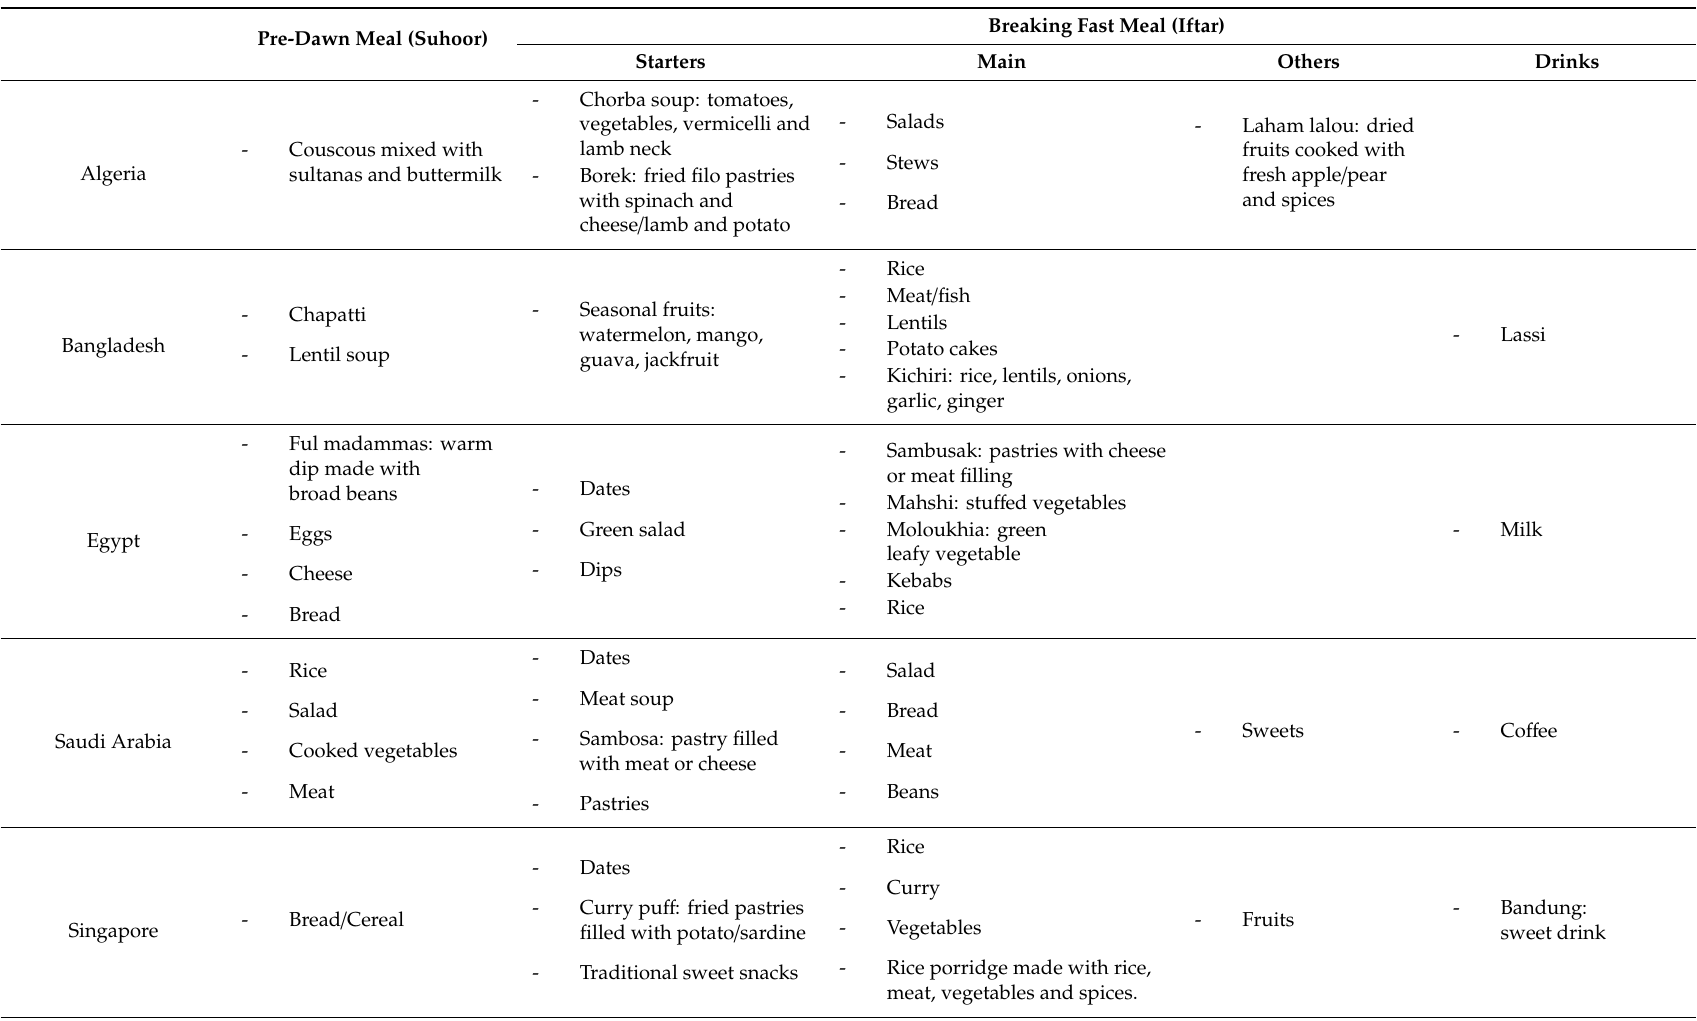
Table 1. Food intake pattern during Ramadan in di ff erent countries around the world [26,27]. Breaking Fast Meal (Iftar) Pre-Dawn Meal (Suhoor) Starters Main Others